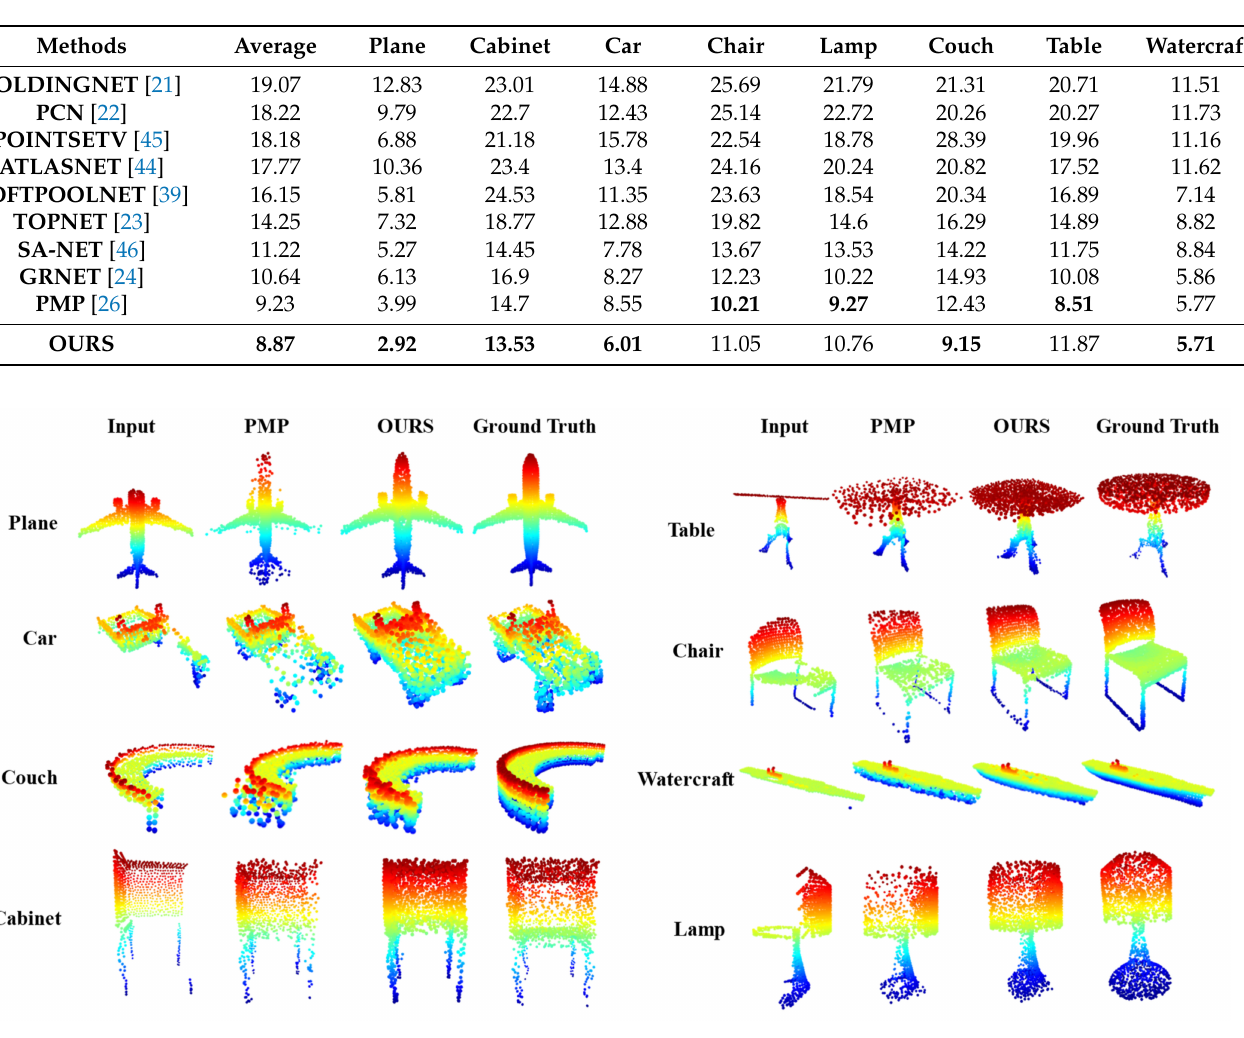
Figure 6. Visual comparison with PMP (the second best algorithm) on the Completion3D dataset. The visualizations completed by MAPGNet (OURS) have a more accurate geometry. Ground Truth is the real complete point cloud corresponding to the